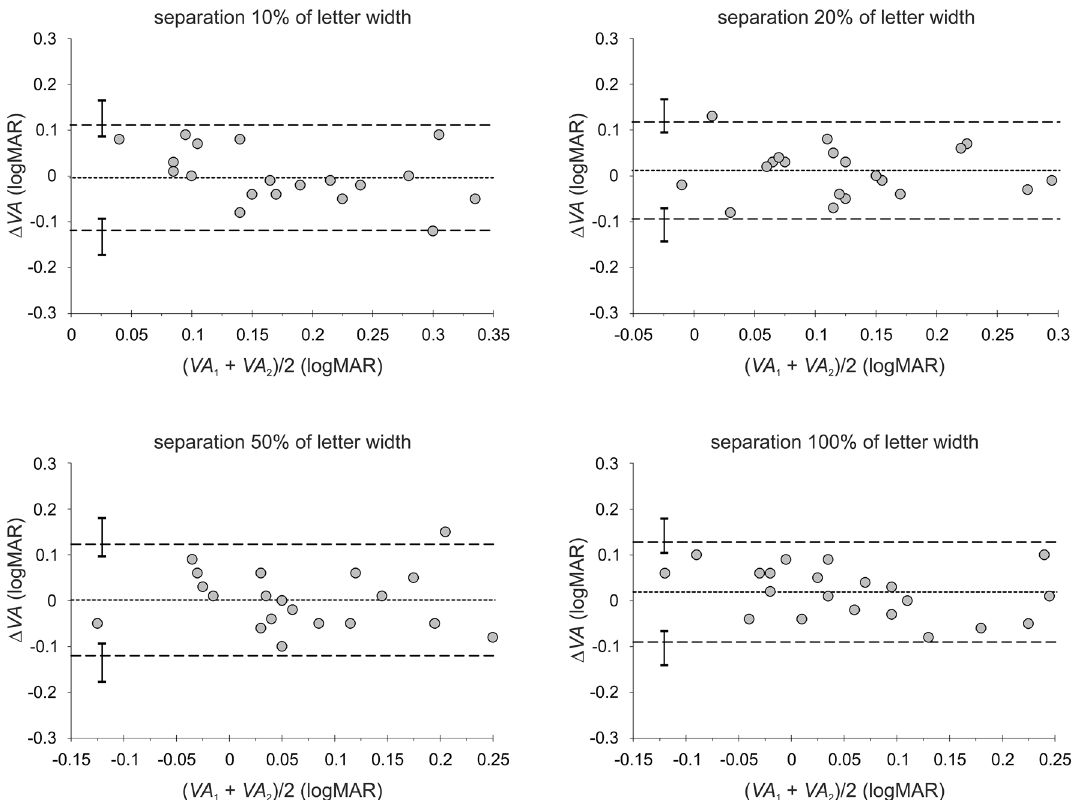
Figure 3. Bland and Altman 43 plots depicting the difference ∆ VA in logMAR between the first VA 1 (test) and second VA 2 (retest) measurements against their average for the intermediate (− 10%) contrast level. The dashed lines represent the 95% limits of agreement (LoA) and the dotted lines the mean differences. The error bars shown in each panel represent the 95% confidence intervals for the Bland–Altman LoAs 44